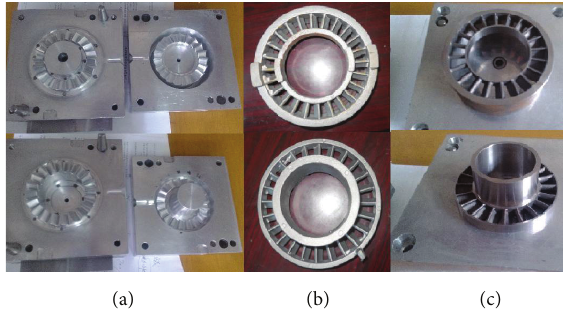
Figure 12: The casting process of the turbodrill blade.